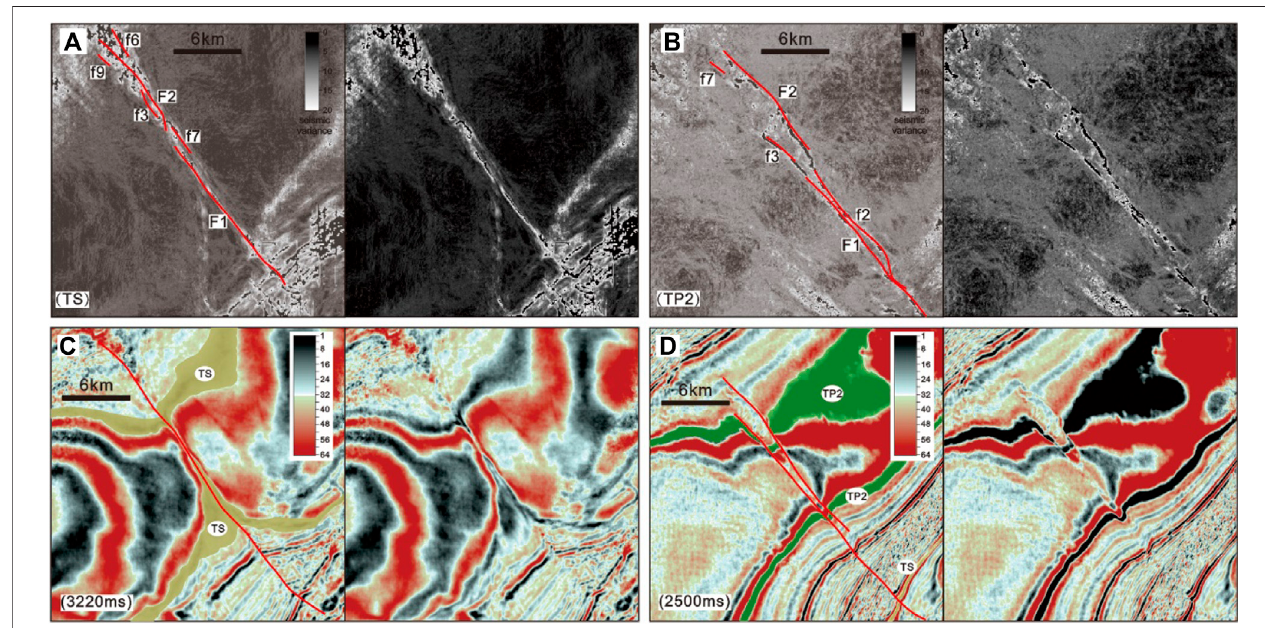
FIGURE5| Interpreted(left)anduninterpreted(right)varianceslicesofthe (A) TSseismicsurfaces, (B) TP1seismicsurfaces, (C) 3220 mshorizontaltimesliceand (D) 2500 ms horizontal time slice covering the south No. 15 fault zone. See the shadow box in Figure 1B for location.